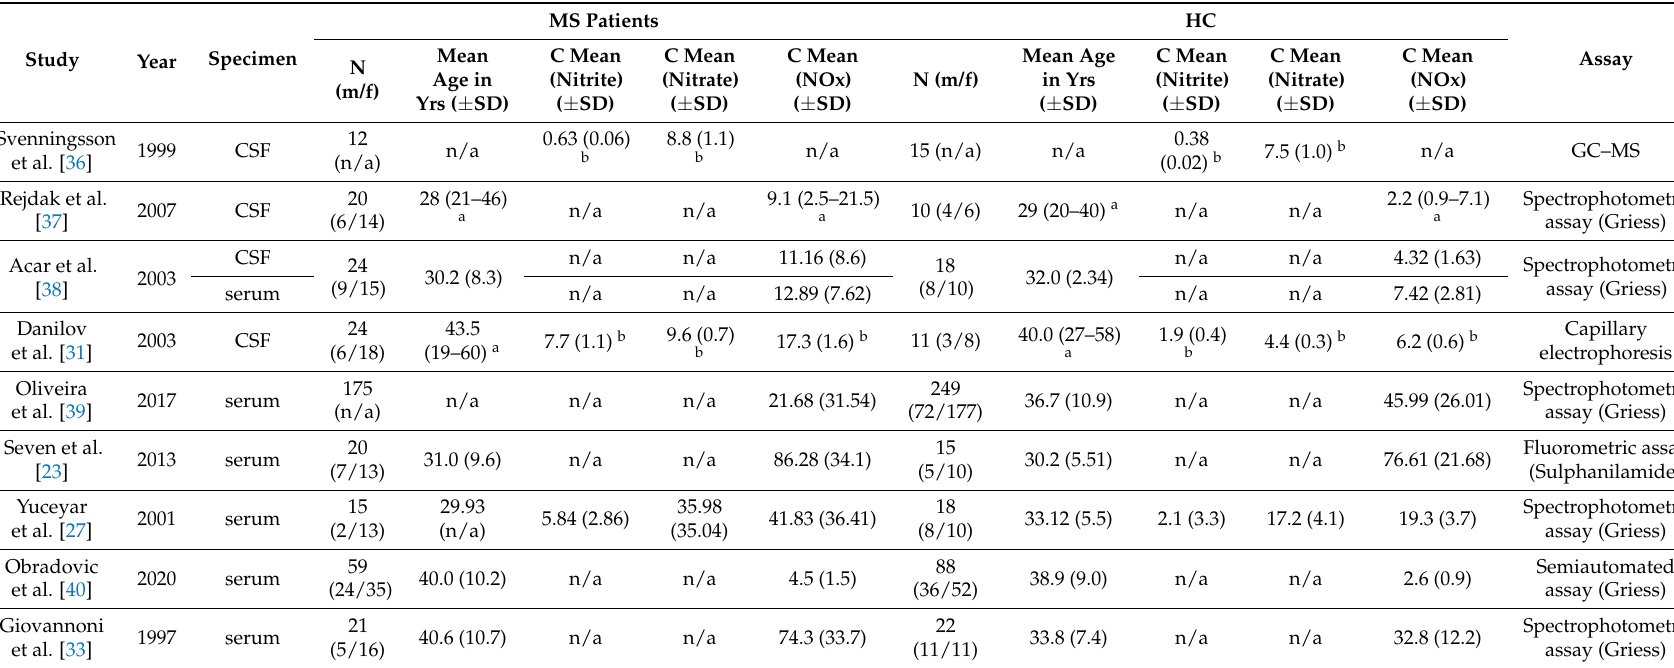
Table 2. Characteristics of included studies investigating nitrite and/or nitrate levels in multiple sclerosis patients (MS) versus healthy controls (HC). CSF